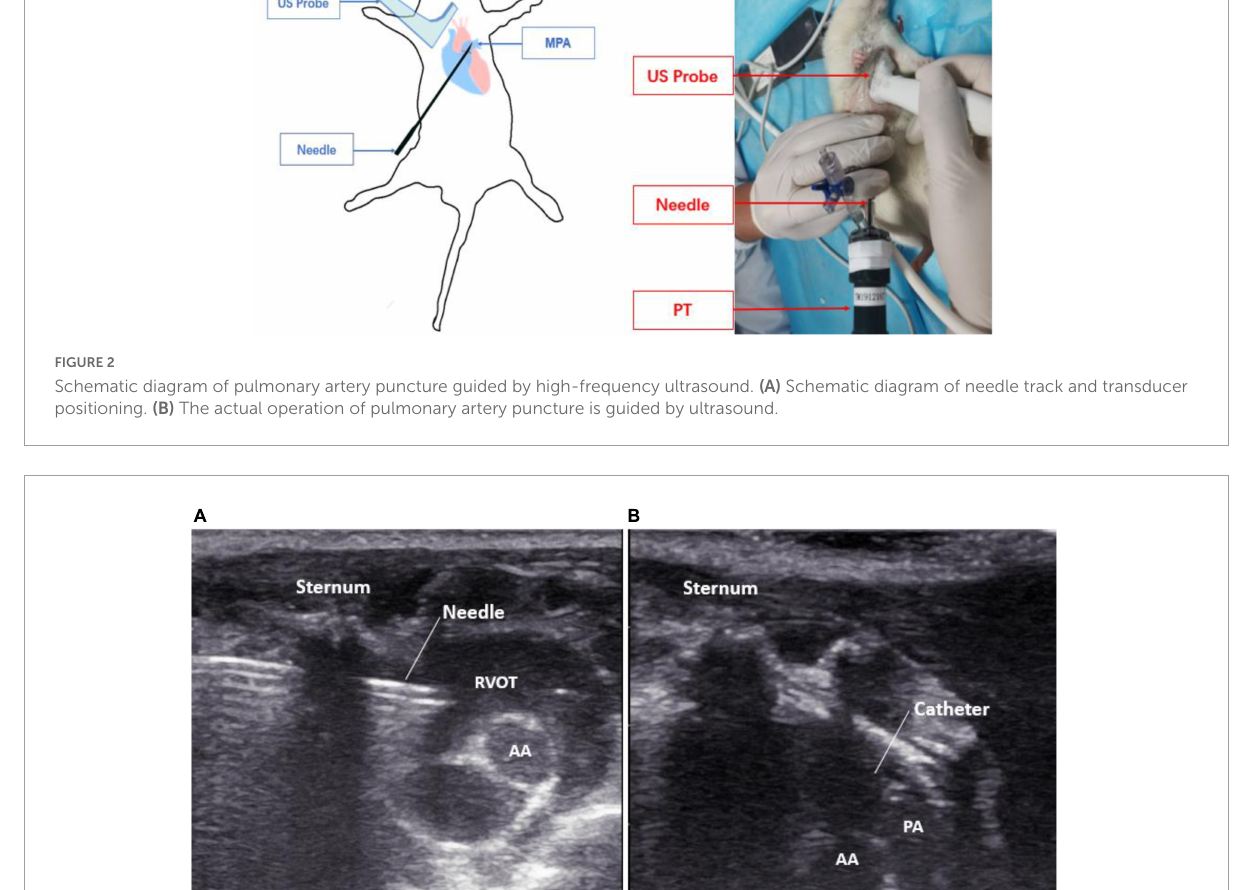
(H&E). The sections were observed under the Nikon 80i microscope (Nikon,